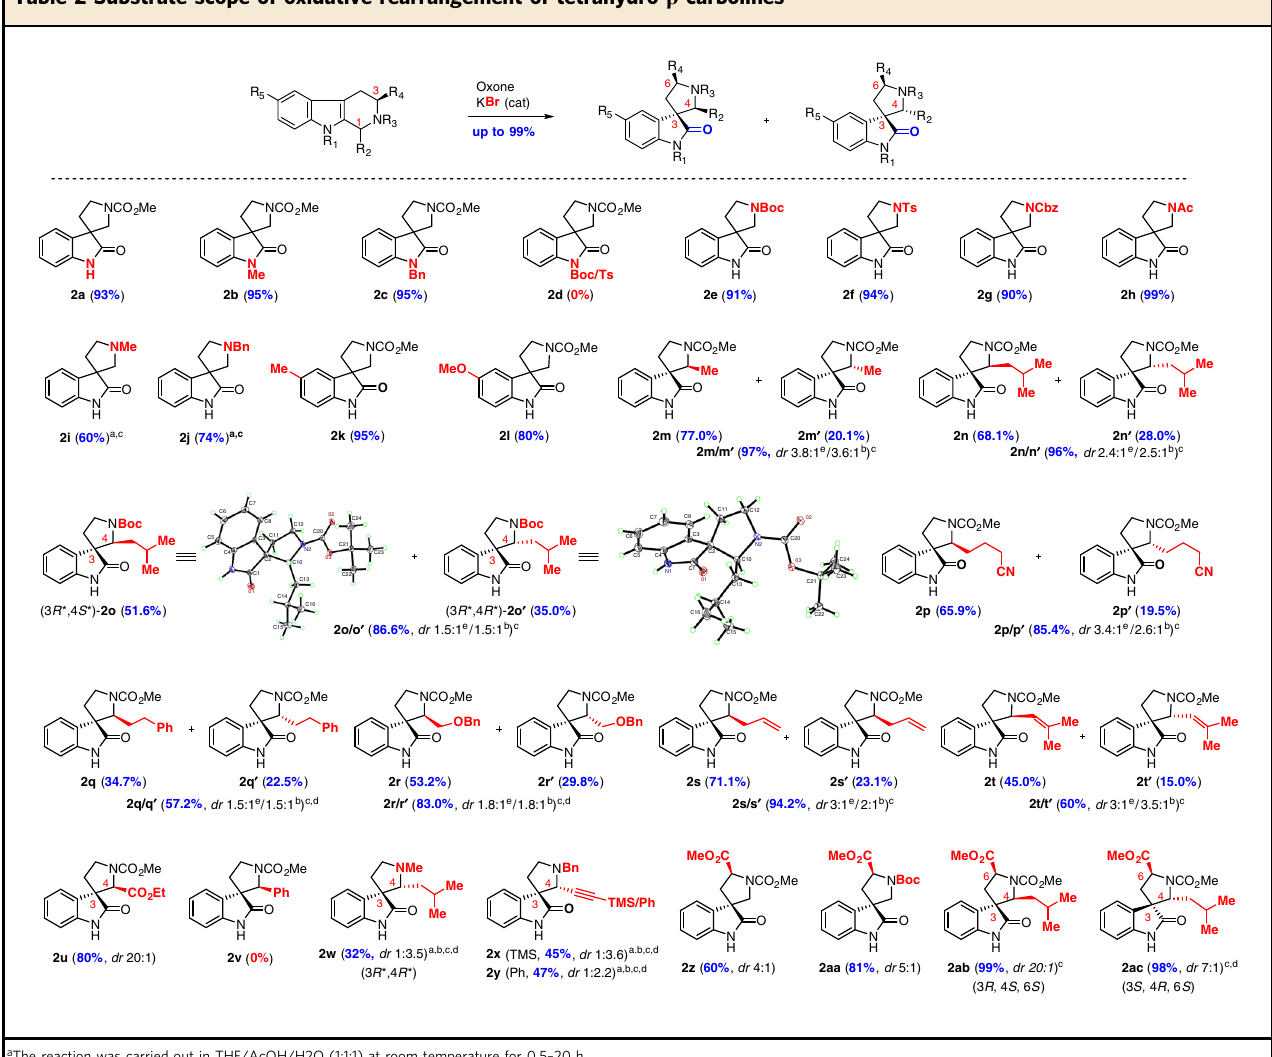
Table 2 Substrate scope of oxidative rearrangement of tetrahydro- β